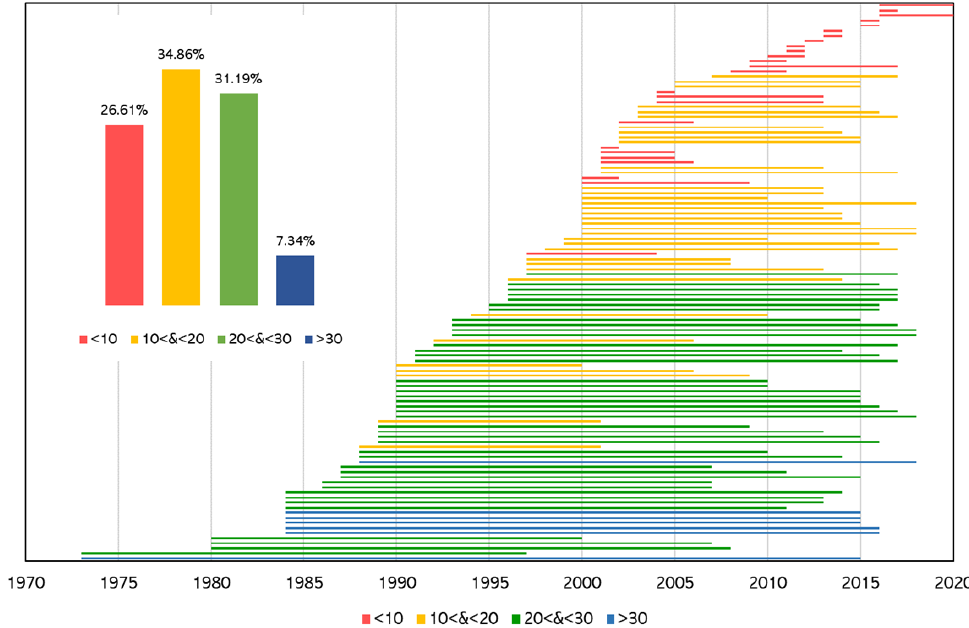
Figure 4. Timeline of study periods considered in the reviewed literature along with the percentage of studies based on different decadal time intervals.